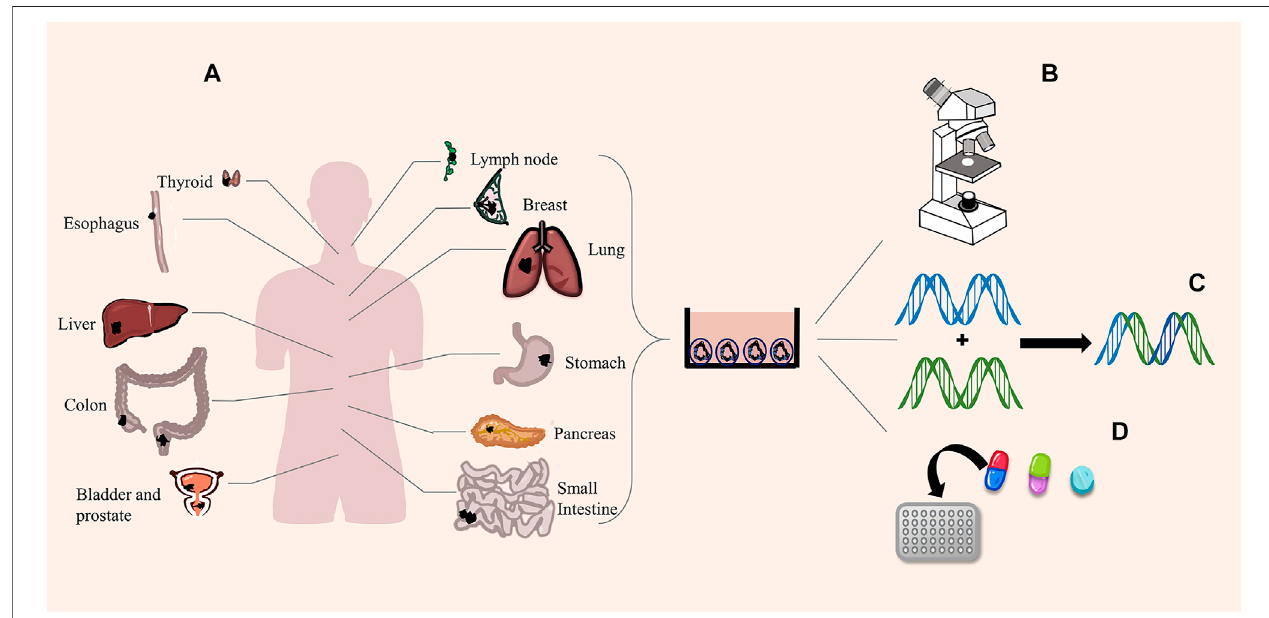
FIGURE 2 | Tumor organoids and functions. (A) Scientists successfully cultured different cancer organoids. (B) Organoids perfectly simulate the pathological expression and tissue structure of tumors. (C) Organoids are suitable for gene editing. (D) High-throughput screening of drugs.